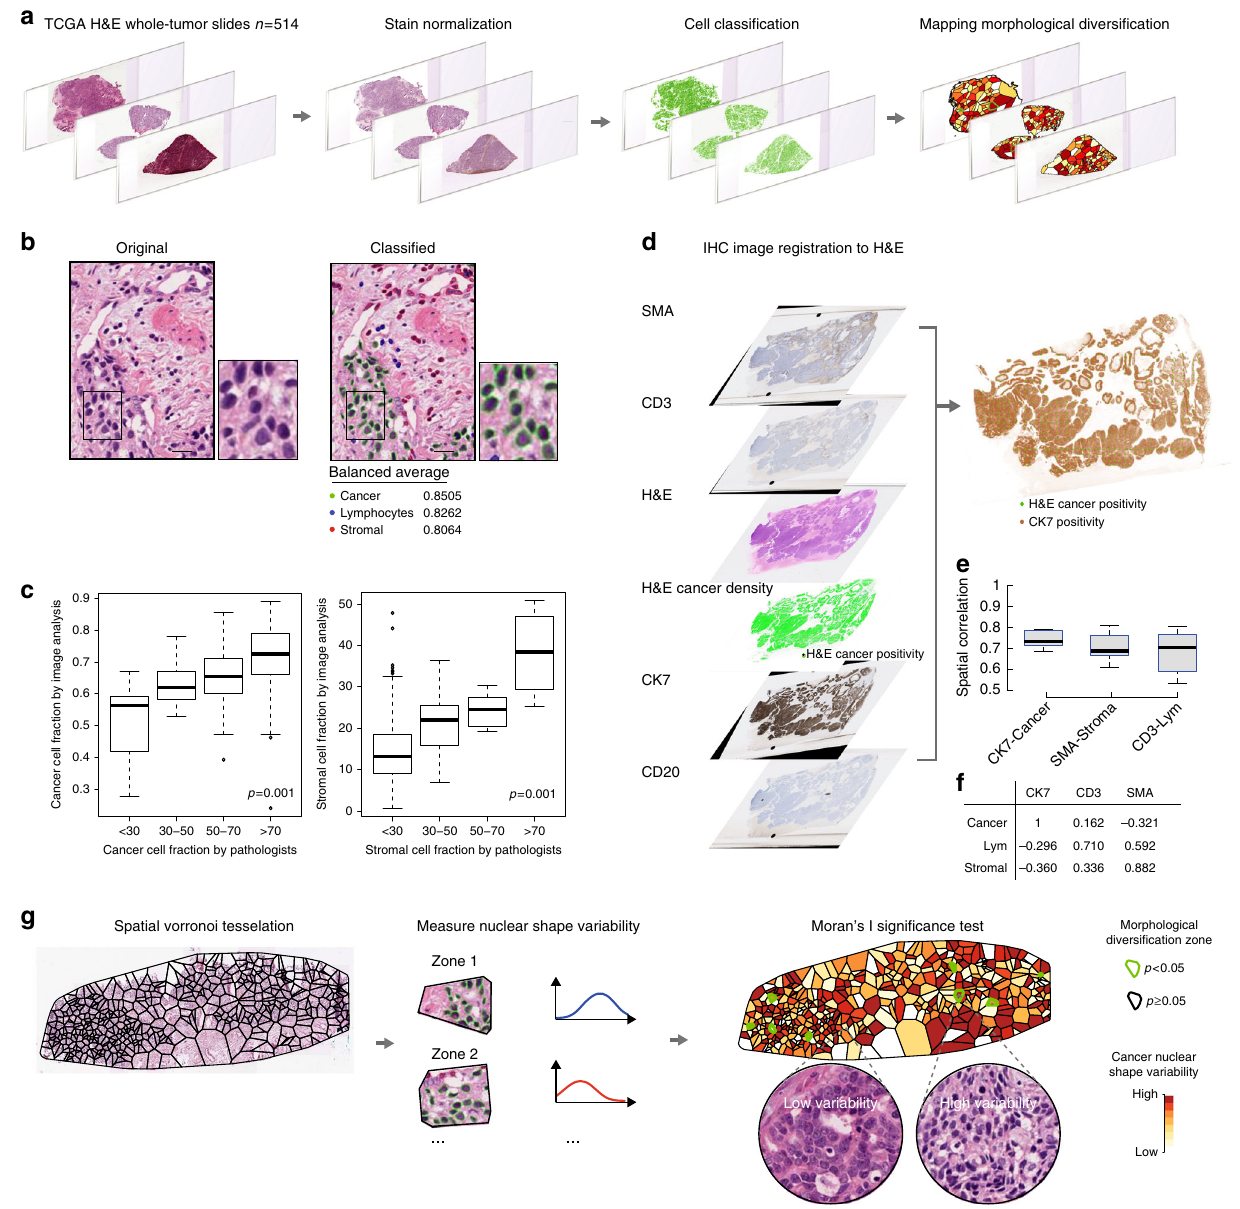
Fig. 1 Our computational pipeline for the identi fi cation of cancer nuclear morphological diversi fi cation zones. a H&E-stained whole-tumor section slides were digitized and stain normalized. Single cells were classi fi ed based on their morphology. Voronoi tessellation was employed to subdivide the tumors into polygons. Morphologically diversi fi ed zones were detected using local Moran ’ s I statistics. b An illustrative example of single-cell classi fi cation: cancer cells (green), stromal cells (red), and lymphocytes (blue). Nucleus boundaries were generated by automated image analysis. Accuracy was assessed using balanced average, which is the mean of sensitivity and speci fi city. Scale bar shows 20 μ m. c Jonckheere trend test of automated versus pathologist ’ s cell abundance scoring of cancer cells and stromal cells as a second method for validation. Boxplot center line, bounds of box and whiskers represent here and henceforth median, inter-quartile range and extreme values (1.5 times inter-quartile range). d Our image registration pipeline for validating H&E image analysis using serial IHC sections. An example of overlaying H&E-based cancer identi fi cation result (green points showing cancer-positive regions) on CK7 was shown. e Boxplot to show the spatial correlation between CK7 and H&E-based estimate of cancer cells, CD3 and lymphocytes, and SMA and stromal cells in all IHC validation samples. f Spearman correlation of sample-level scores from H&E image analysis (Cancer%, Lymphocyte%, Stromal%) versus IHC CK7, CD3 and SMA scores. g An illustrative example of running local Moran ’ s I analysis: a tumor section was spatially divided using Voronoi tessellation; cancer cell nuclei in each zone analyzed with respect to shape variability; and the resulting heatmap of shape data superimposed with signi fi cance test results. Images are for illustrative purpose only and do not re fl ect actual size of the spatial zones. Heatmap colors represent shape variability of cancer cell morphology in the spatial zone. Spatial zones identi fi ed to be morphologically diverse were outlined in